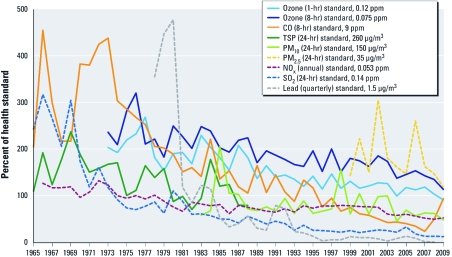
Overall trend for all the criteria air pollutants in New Jersey, 1965–2009, for the annual maximum measured at all monitoring sites in the state shown as a percentage of a pollutant’s level above or below the NAAQS. Historical New Jersey air monitoring data prior to 1975 was received from C. Pietarinen (personal communication) and other data from AirData (U.S. EPA 2011).